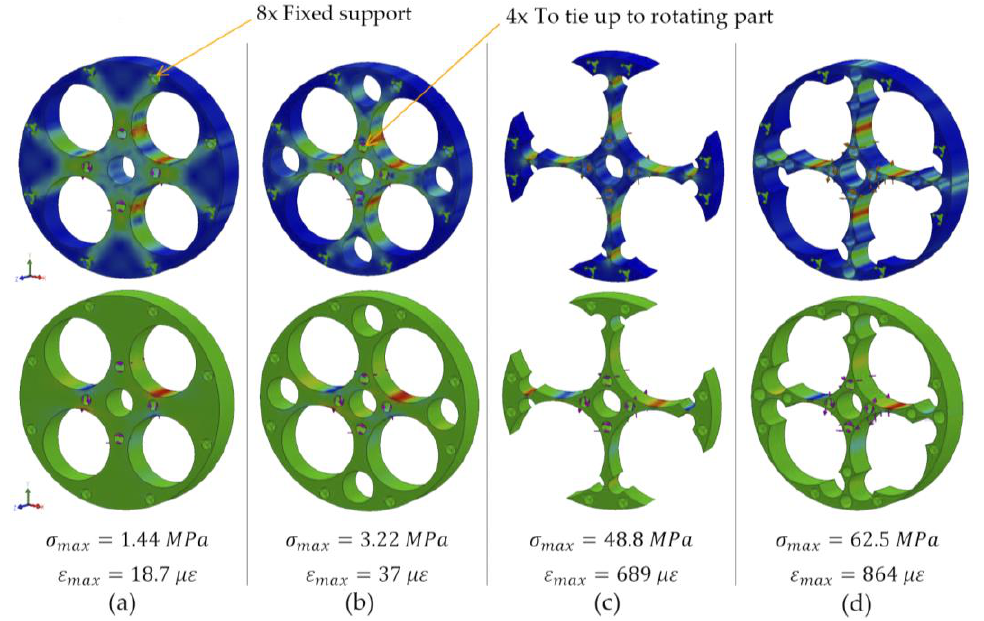
Figure 6. Example of different geometries, ( a – d ) with the results of CAE analysis.